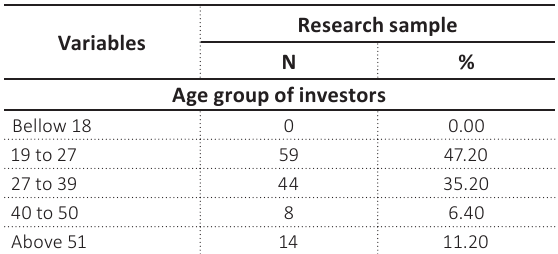
Table 2. Descriptive statistics of the research